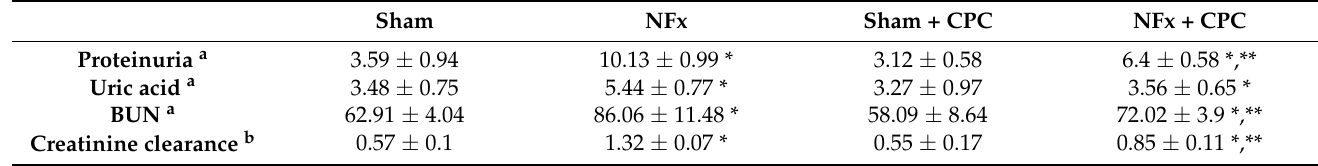
Table 1. Effect of 100 mg/kg CPC administration on renal function in NFx rats. Sham NFx Sham + CPC NFx + CPC Proteinuria a 3.59 ±